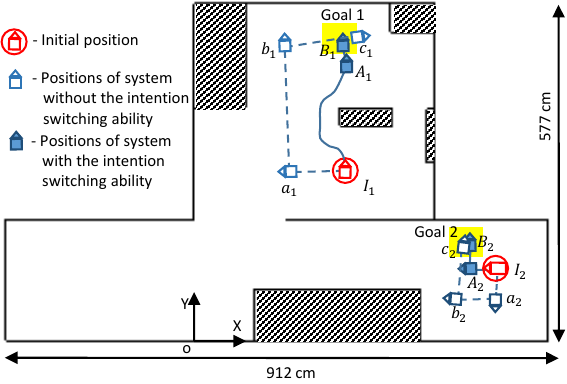
Figure 9. The positions of the robot after executing each user instructions given in Table 3 for cases 1 and 2 are marked on the map with the corresponding indexes. The shaded areas represents the objects in the environment. The light color solid areas represent the positions of the goals. The map is drawn to a scale. However, it should be noted that the markers do not represent the actual size of the